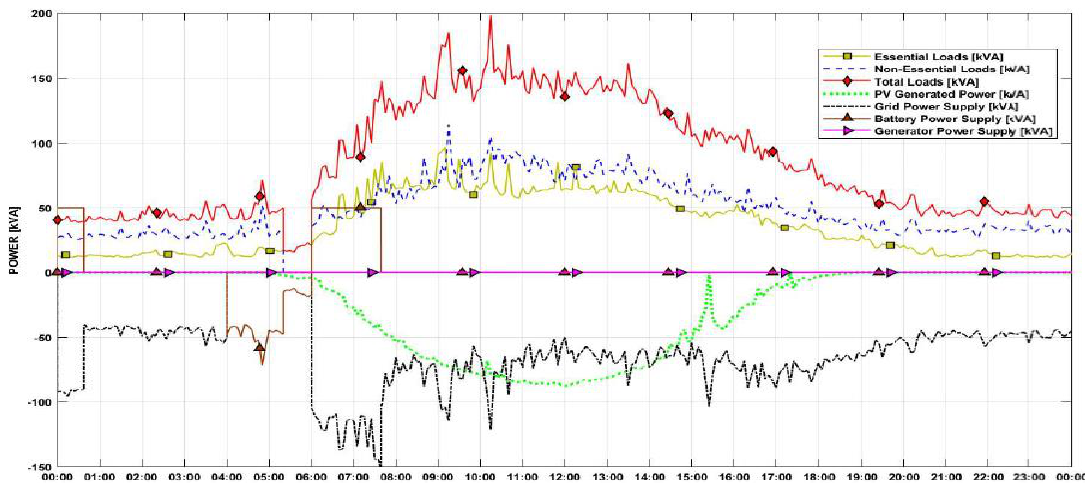
Figure 16. The behavior of MCAST micro-grid integrated with a 150 kWh BESS and 150 kVA diesel generator during a 2-h power cut.